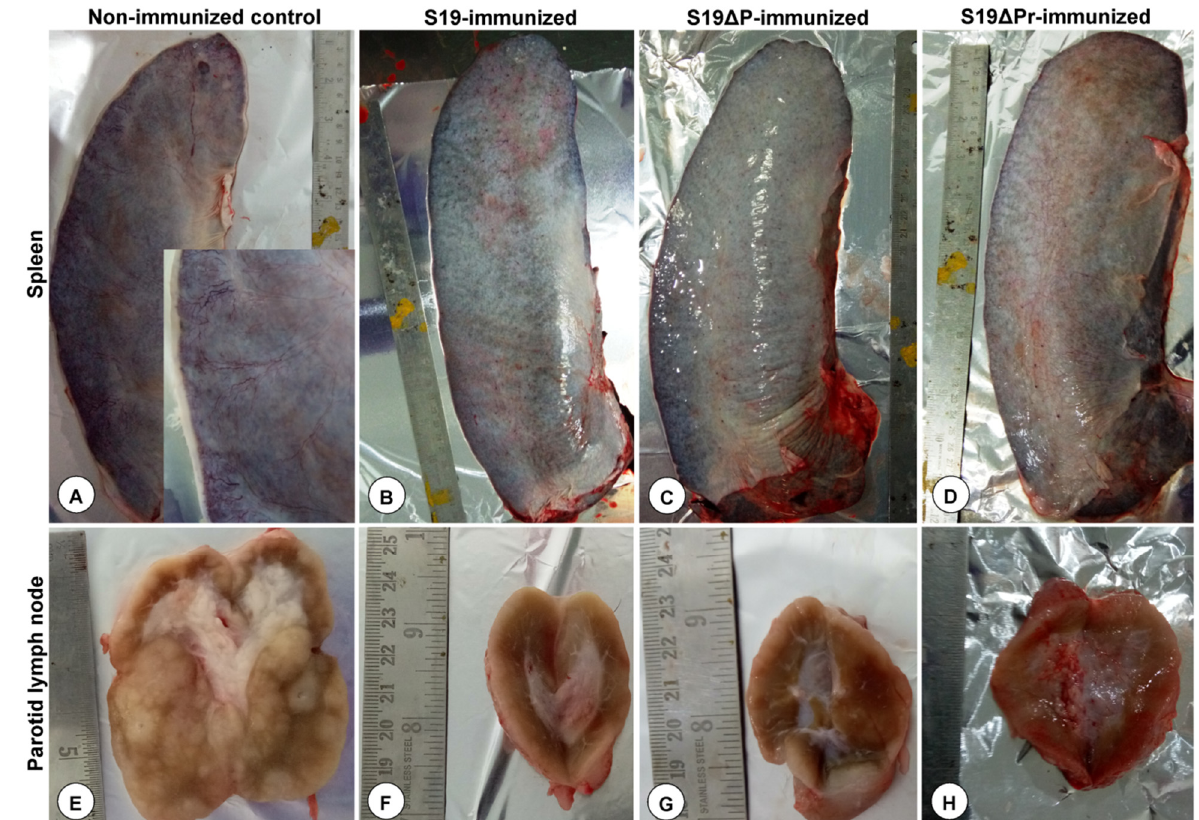
Figure 7. Post-challenge assessment of the gross lesions in the immunized buffaloes. ( A ) Enlarged spleen with marked thickening of capsule especially at the borders, oedema, and congested serosal blood vessels (inset). ( B – D ) Moderately enlarged spleen. ( E ) Markedly enlarged parotid lymph node (LN). Cut section revealed bulged surfaces with focal necrosis and increased cortical area than medulla. ( F – H ) Moderately enlarged parotid LN.